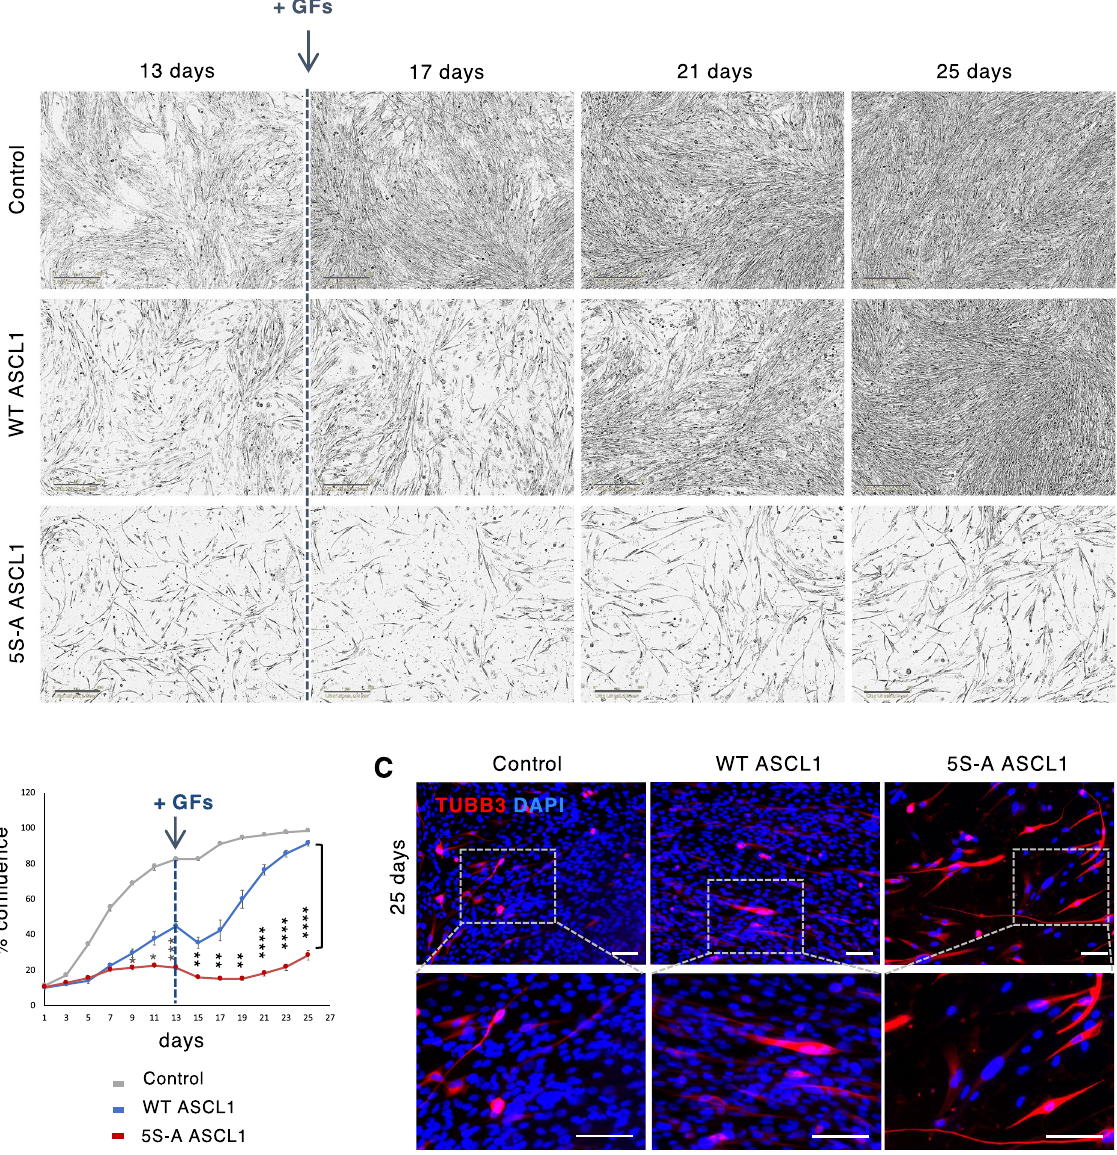
Figure 3. Dephosphorylated ASCL1 promotes stable mitotic exit and differentiation. ( A ) Representative images of G144 cells after removing ASCL1 induction and re-addition of growth factors. Scale bars: 300 μm. ( B ) Quantification of cell confluence. Data: mean ± SEM n = 2 independent experiments for Control + GFs and n = 3 independent experiments for the other conditions; one-way ANOVA followed by the Bonferroni post- hoc test; * p < 0.05; ** p < 0.01; *** p < 0.001; **** p < 0.0001. All data points from day 3 onwards are statistically different between control and WT ASCL1 and between control and 5S-A ASCL1 ( p < 0.05; not shown). ( C ) Immunostaining showing persistent expression of the neuronal marker TUBB3 (red) at 25 days of culture. Scale bars: 50